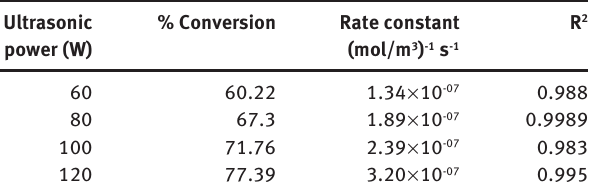
Figure 10 Relationship between ln (k) and 1/T as per Arrhenius’